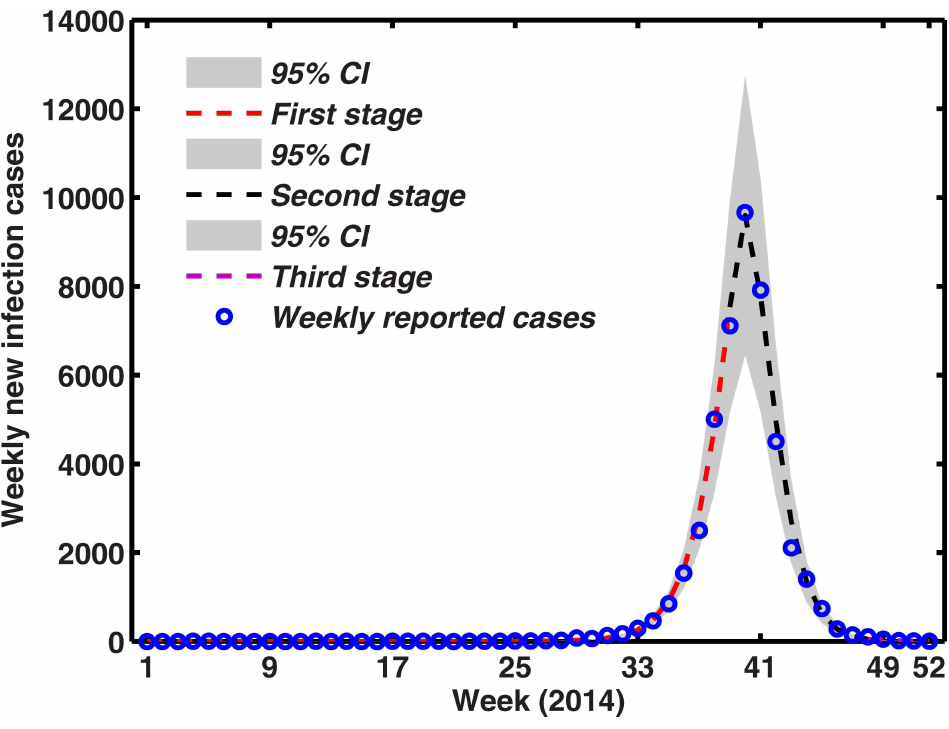
Fig 8. The simulation result of weekly new infection dengue cases in Guangdong in 2014. Blue circles indicate the number of weekly reportedinfectioncases, light grey shaded area for the 95% confident interval (CI) for all 1000 simulations, while the red, blue and purpledotted lines are the medianfor all model outputs with the first, second and third stage, respectively. The first and third stage without any interventions, the second stage with